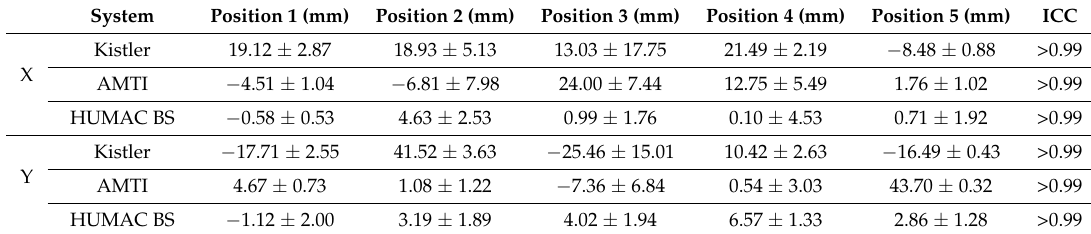
Table 1. Average error and standard deviation for the static condition in x and y direction.